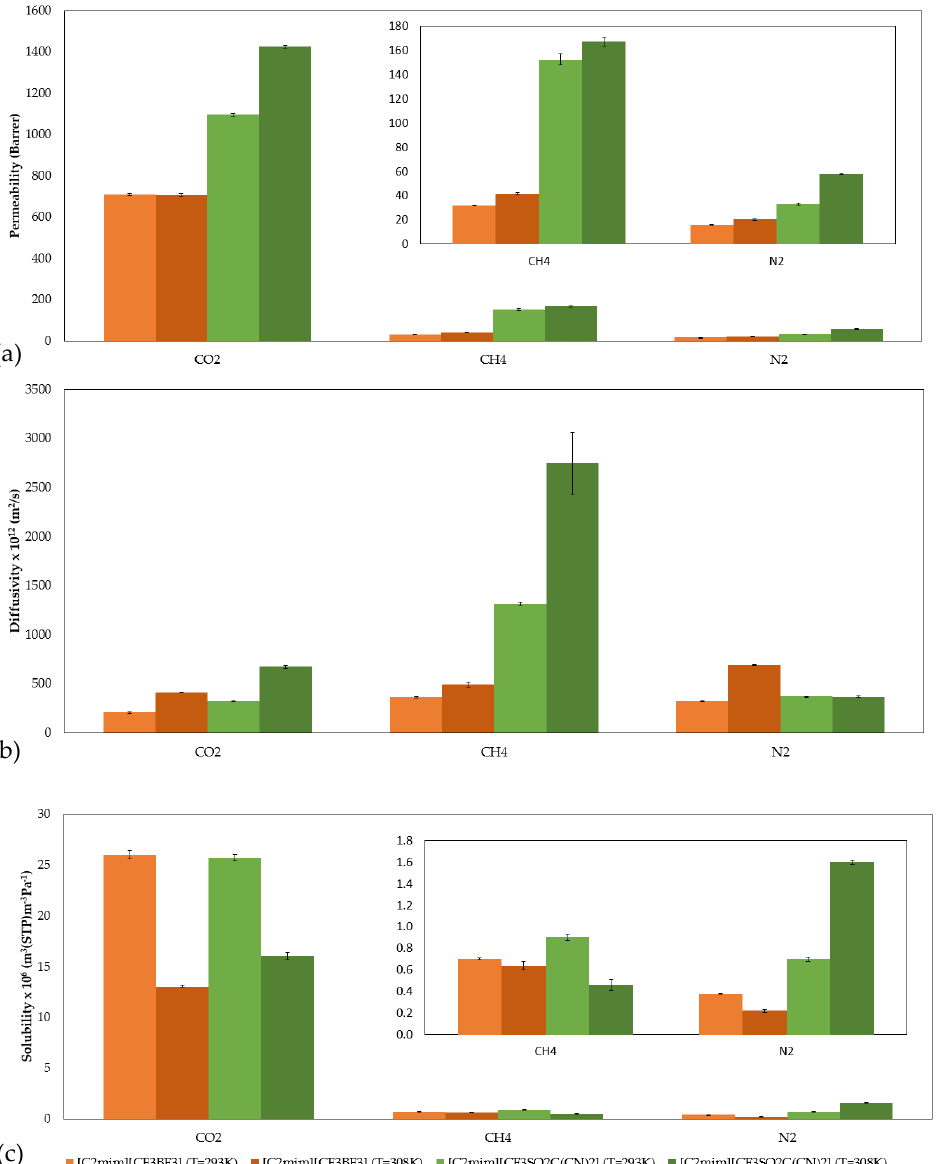
Figure 5. Comparison of ( a ) gas permeability, ( b ) diffusivity (D), and ( c ) solubility (S) of CO 2 , N 2 , and CH 4 for [C 2 mim][CF 3 BF 3 ] and [C 2 mim][CF 3 SO 2 C(CN) 2 ] at 293.15 K and 308.15 K.